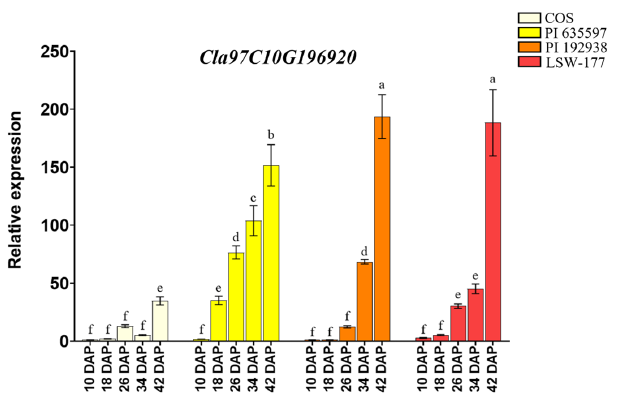
Figure 4. Relative expression of MYB transcription factor Cla97C10G196920 in four watermelon varieties with different fruit colors at five time points (10, 18, 26, 34, 42 days after pollination). Additionally, the fruit sample COS at 10 DAP was used for calibration. The bars represent the means ± SD (n = 3). Different lowercase letters indicate significant differences at p -value <